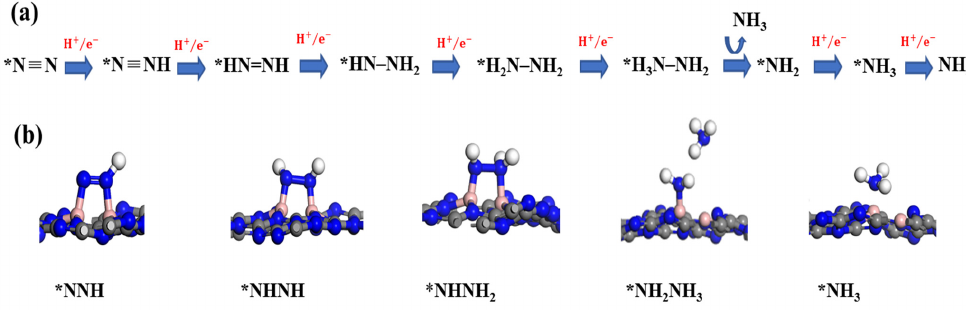
Figure 6. Free energy diagrams for NRR on B2@C 3 N 4 along the most favorable pathway (i.e., the enzymatic pathway) at different applied potentials. The selectivity of catalysts between NRR and the competing HER was investigated. Figure 7. The hydrogen adsorption Gibbs energy change is − 2.36 eV, and ∆𝐺 (*N 2 ) is 1.78